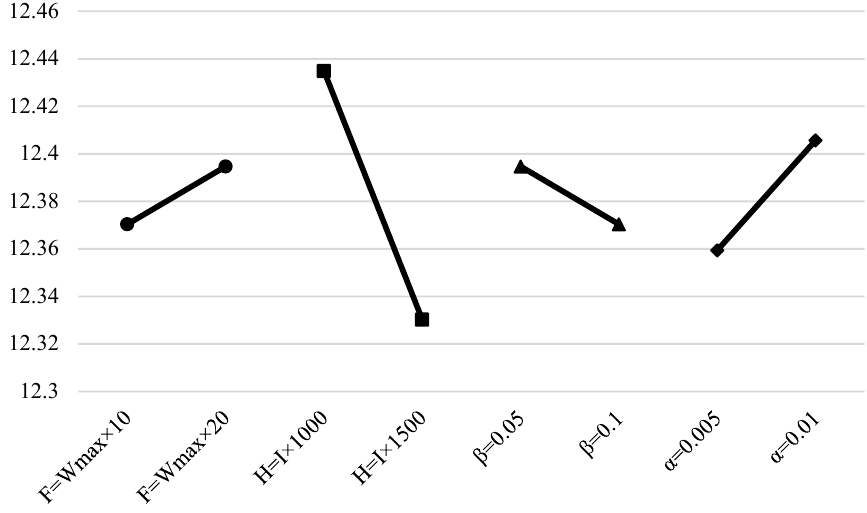
Figure 12. The main effect of cycle Figure 12. T he main effect of cycle time.